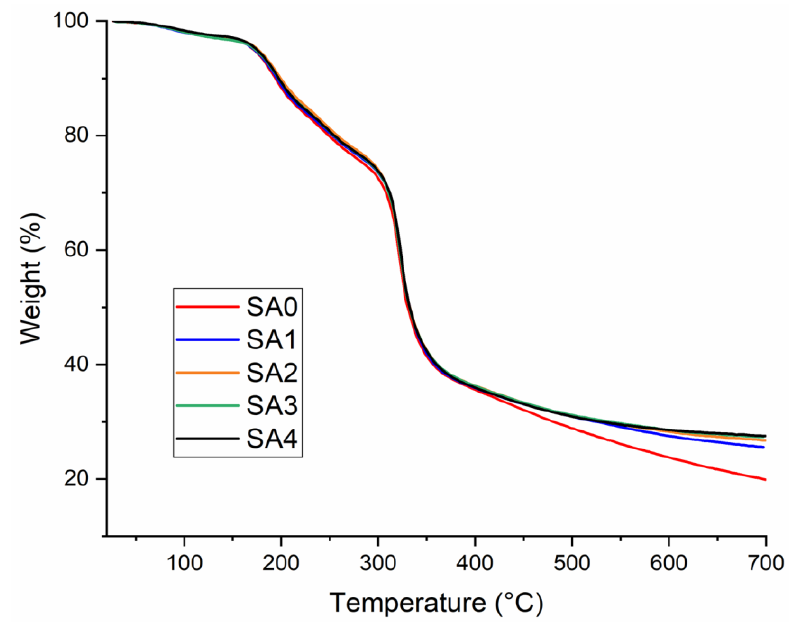
Figure 6. Thermal properties of the obtained samples.